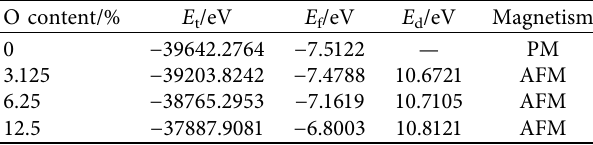
2 in which the red sphere represents oxygen Table 2: Normalized total energy E t , formation enthalpy E f , oxygen defect formation energy E d , and magnetism for anatase TiO 2